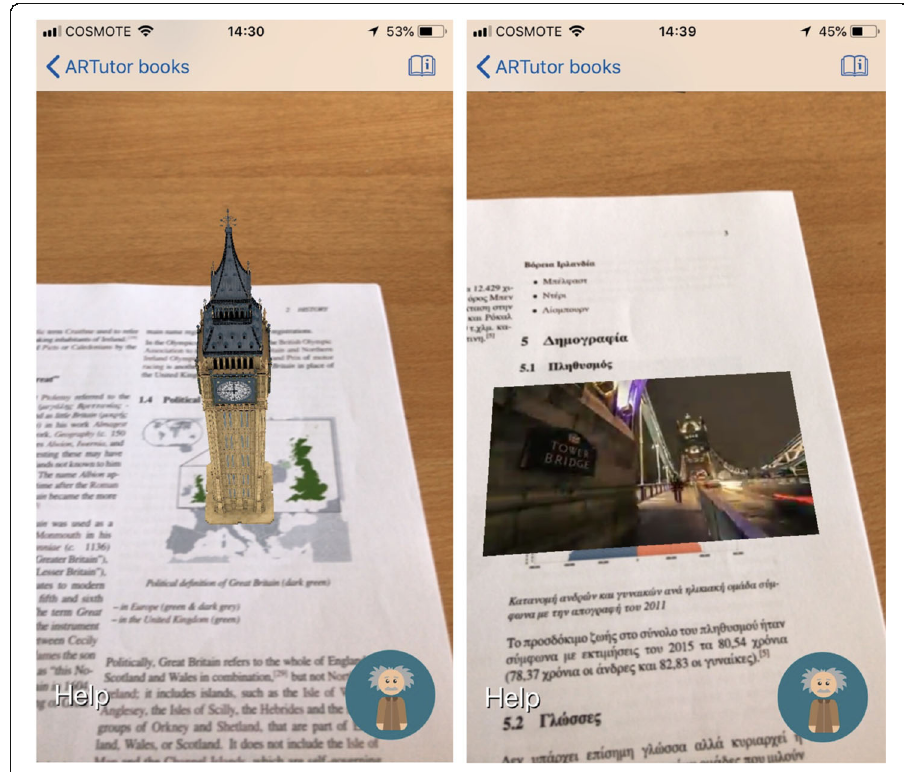
Fig. 4 Example augmentations using the ARTutor mobile application